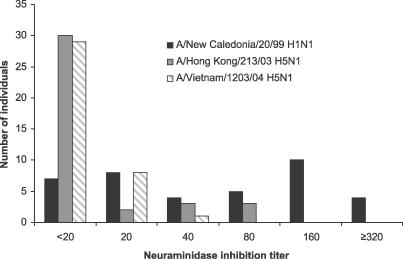
Reactivity of Human Donor Sera with NA of H1N1 and H5N1 Influenza VirusesSerum samples from human donors were analyzed by NA inhibition assay for reactivity with the NA proteins of A/New Caledonia/20/99 (H1N1), A/Hong Kong/213/03 (H5N1), and A/Vietnam/1203/04 (H5N1).